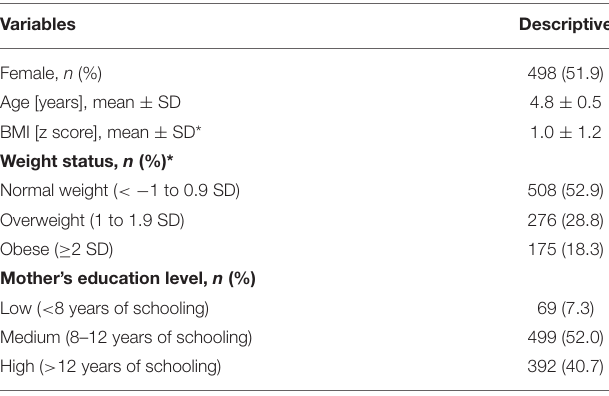
TABLE 1 | Sociodemographic variables, weight status, and energy intake among the participants ( n = 960). Variables